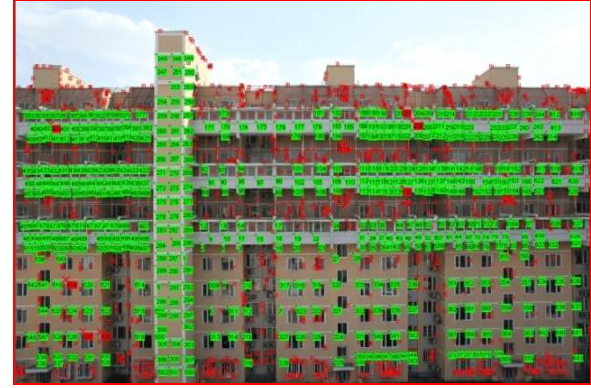
Figure 3. Image point distribution of camera calibration